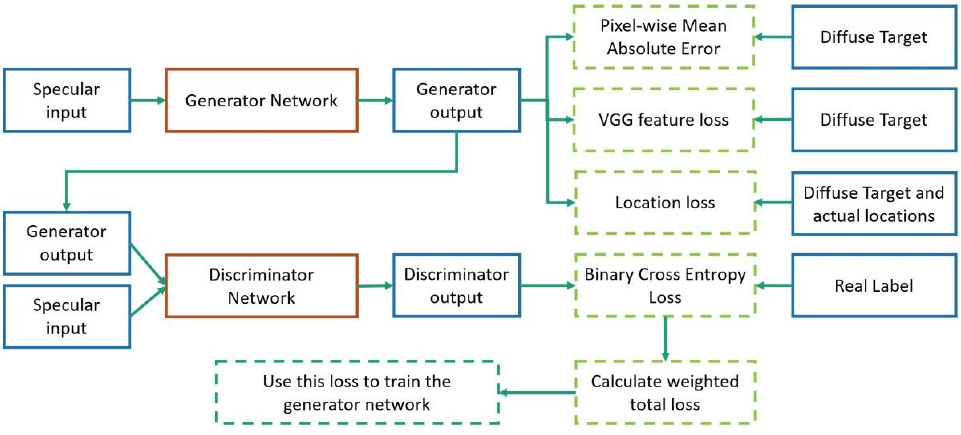
Figure 15. The flow of generator training process.